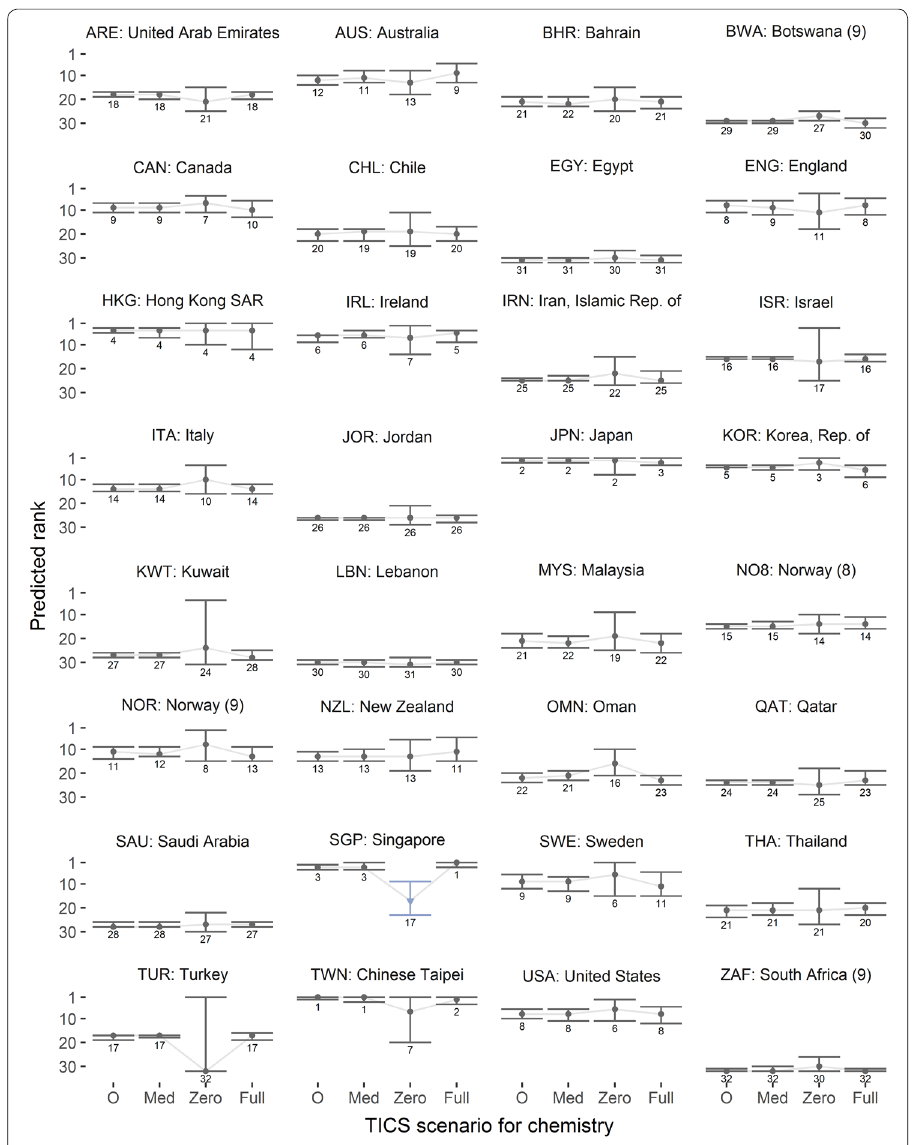
Fig. 15 Predicted rank in chemistry across TICS scenarios. O Full all schools have implemented the country-specific median, the least possible, or most possible level = of TICS within the country, respectively. A blue confidence interval with a downward arrow indicates a significantly lower rank than the original scenario (e.g. Qatar for zero TICS scenario in